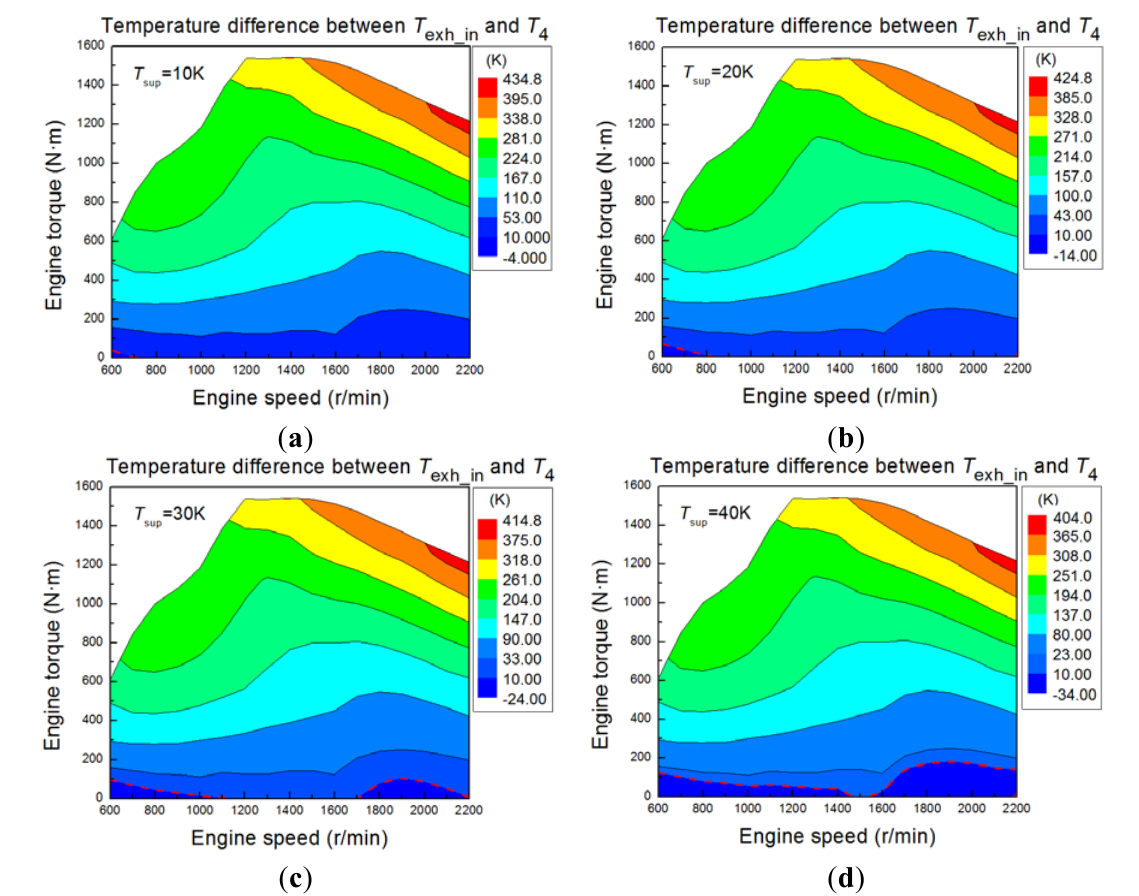
and T : ( a ) T = 10 exh_in 4 sup